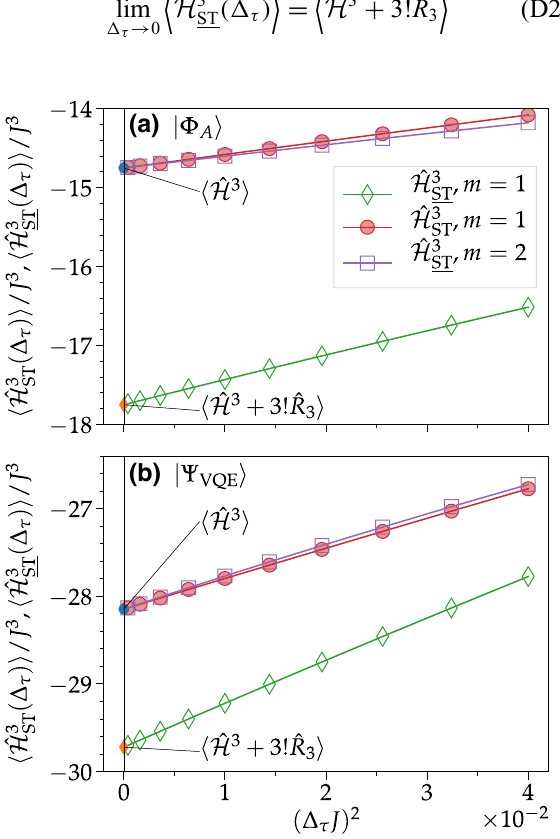
ˆ H 3 ((cid:3) ) (cid:3) and (cid:9) ˆ H 3 ((cid:3) ) (cid:3) as a function of (cid:3) 2 FIG. 19. (cid:9) τ τ τ evalu- ST ST ated for the spin-1 / 2 Heisenberg model on an N = 16 qubit ring, using different orders of the symmetric Suzuki-Trotter decompo- ˆ ( p ) with m = 1, 2 and p = 3. For a quantum state | (cid:6) (cid:3) , we sition S 2 m choose (a) the singlet-pair product state | (cid:17) A (cid:3) in Eq. (80) and (b) the VQE state | (cid:6) VQE (cid:3) in Eq. (88). The exact values are indicated at (cid:3) τ = 0 with the filled symbols (blue and